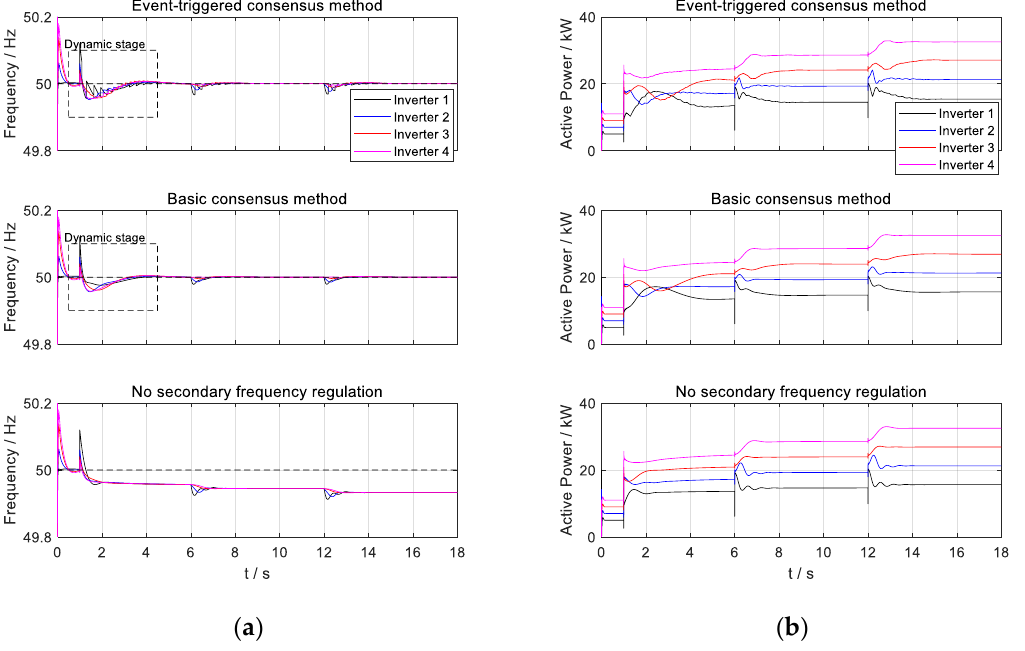
Figure 9. Frequency dynamics and output power dynamics under different control schemes: ( a ) frequency response curve; ( b ) output power response curve.